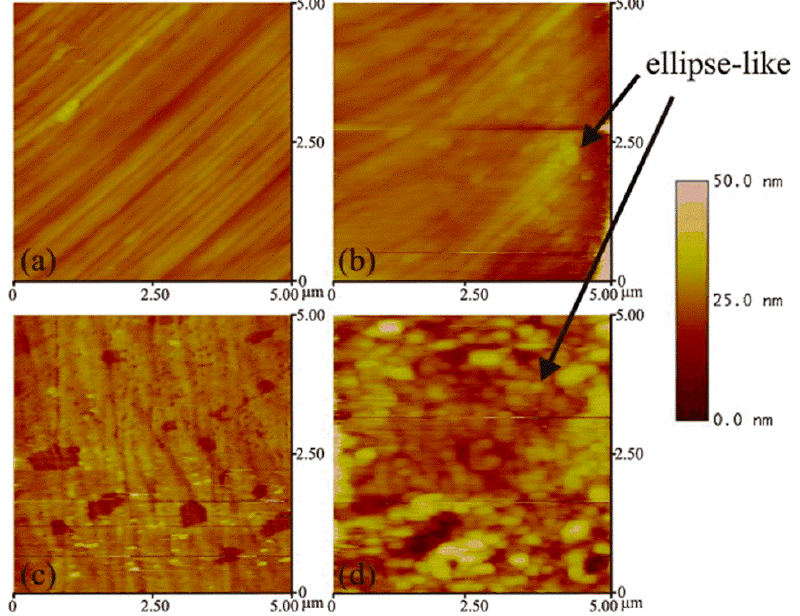
Figure 9. AFM image of AISI 316L sample: ( a ) in AS after exposing the sample to anodic potential of 0.5 V for 10 min, ( b ) in AS after additional exposure of the sample to 0.5 V for 6.6 min, ( c ) in PS immediately after the test cyclic voltammogram in the range of potentials from − 0.5 V to 0.8 V, and ( d ) in PS after additional exposure to 0.5 V for 30 s. Adapted with permission from Reference [45]; copyright 2011 Elsevier Ltd.